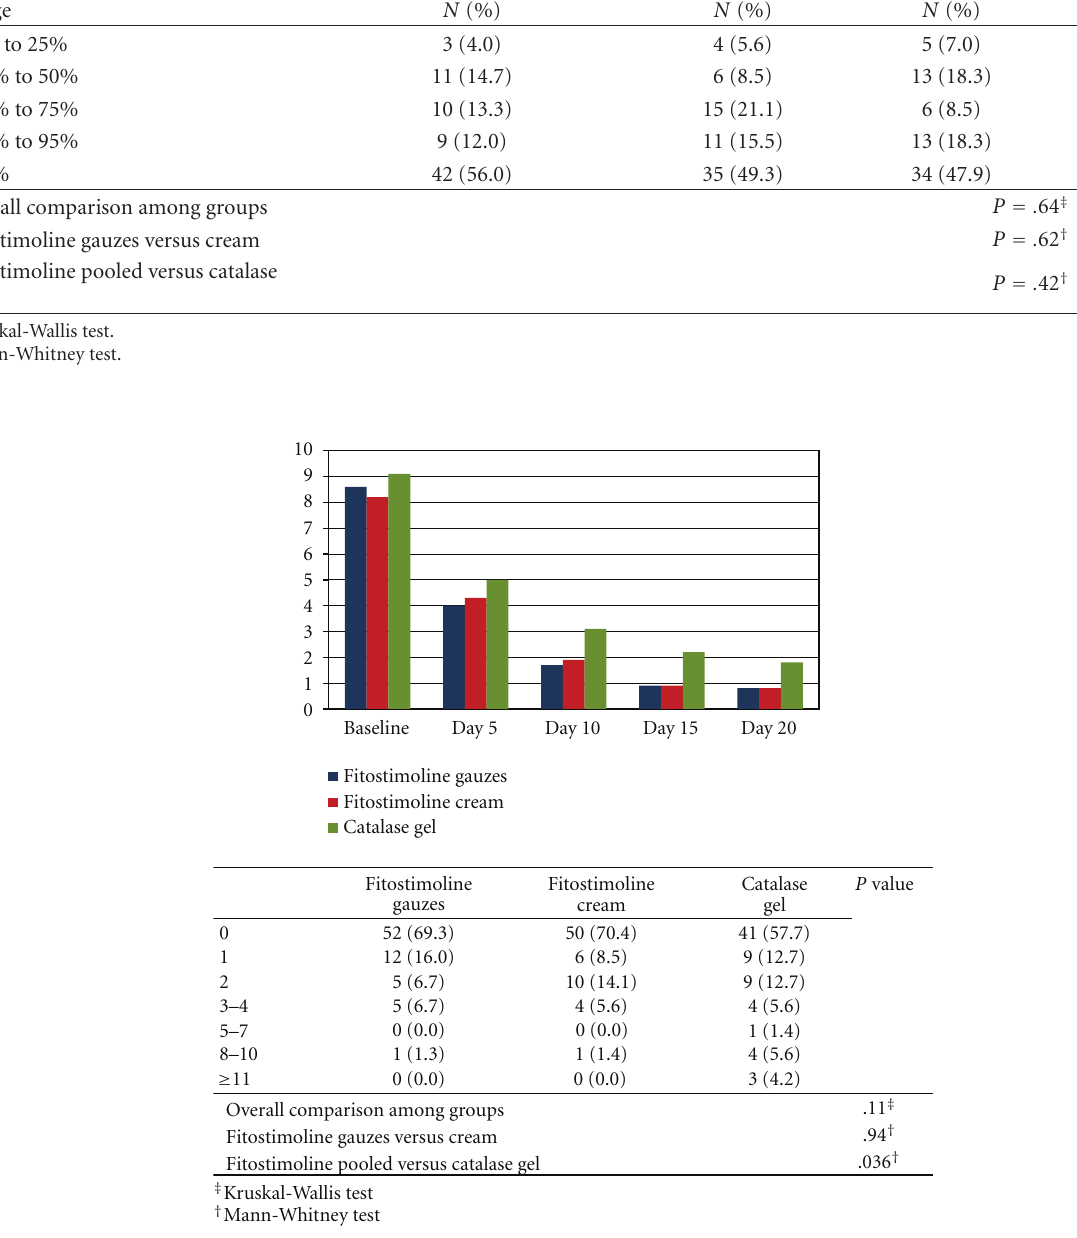
Figure 3: Mean values of total symptoms score during the study and results of comparisons between groups at end of study (e ffi cacy